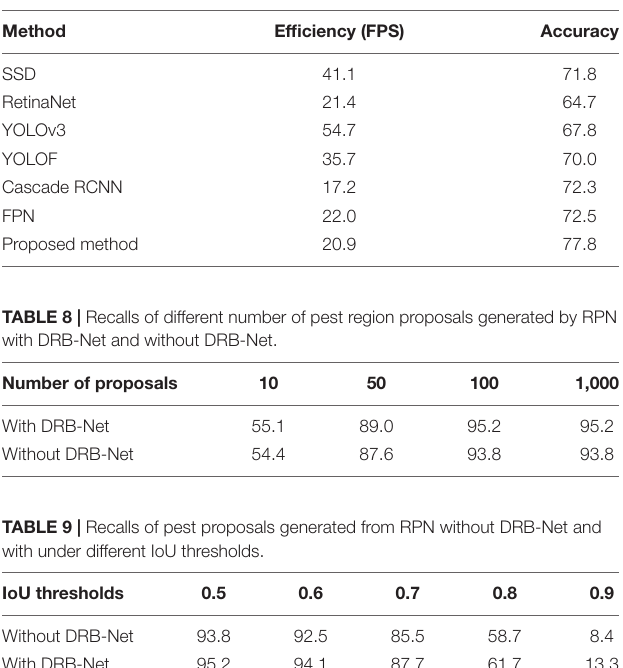
TABLE 7 | Detection efficiency of agricultural pest using our method and other state-of-the-art